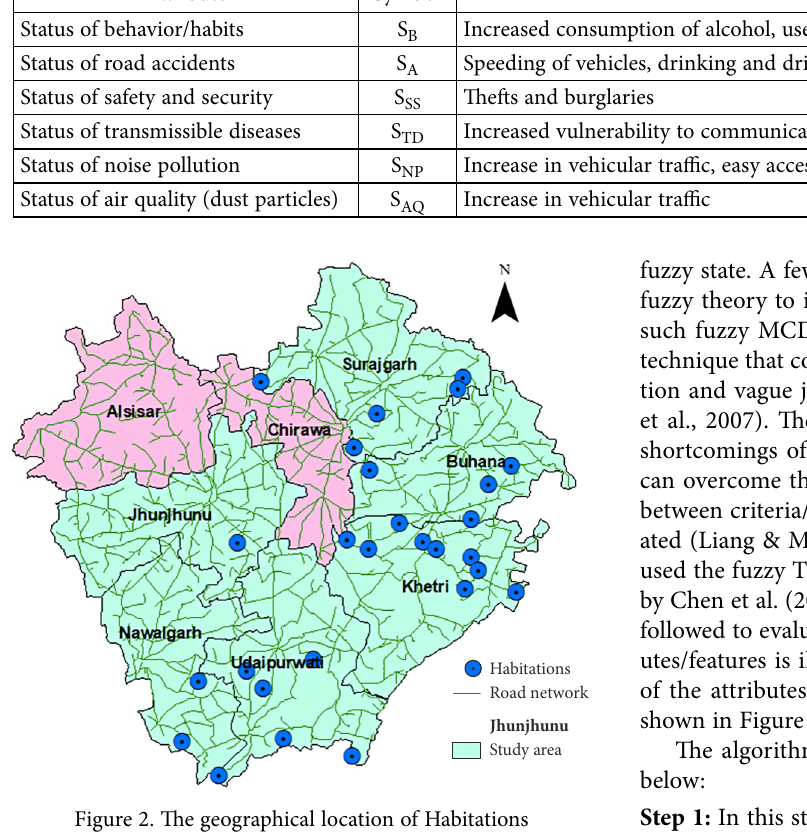
Figure 2. The geographical location of Habitations